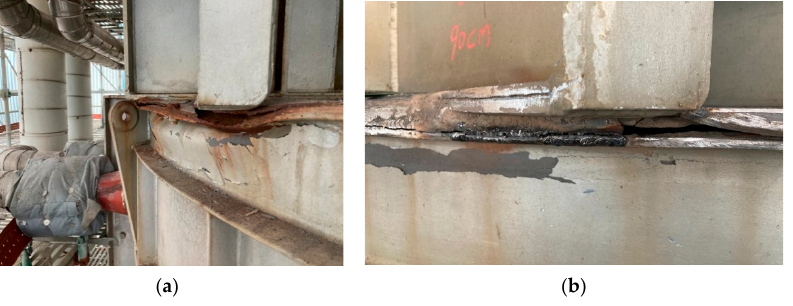
Figure 6. Fatigue failure of the support frame before reinforcement: ( a ) at the south ‐ east side; ( b ) at the north ‐ west side.